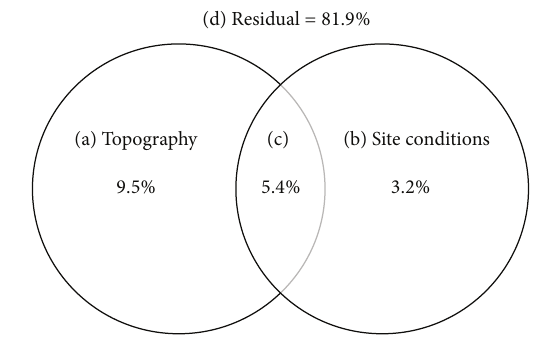
Figure 2: Partition the variation in understory species composition on topographic variables and site conditions. Pure and overlapping effects: (a) pure topography; (b) pure site conditions; (c) overlapping effects; (d)